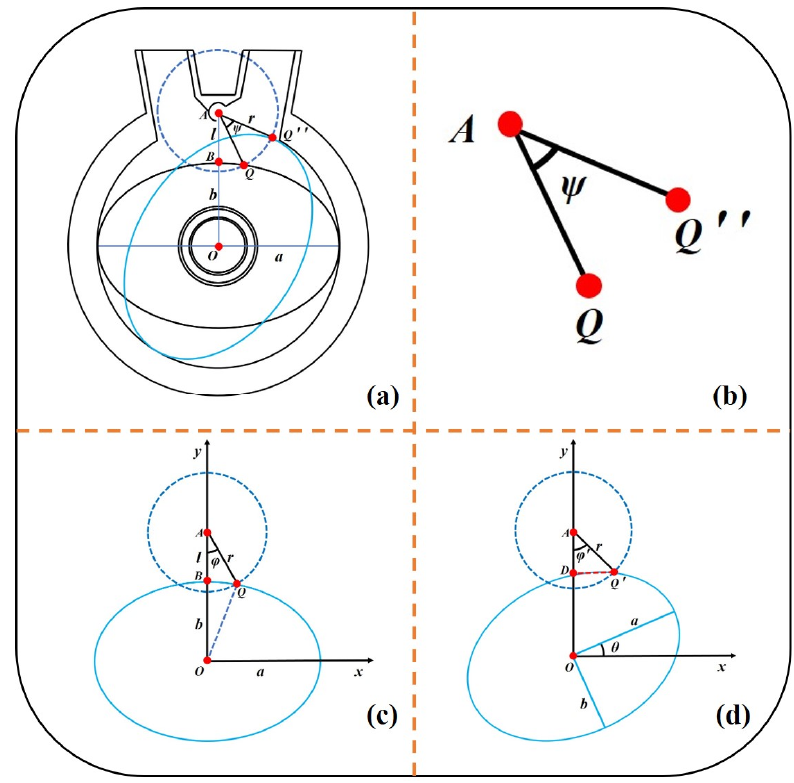
Figure 3. Mathematical Model Auxiliary Diagram.